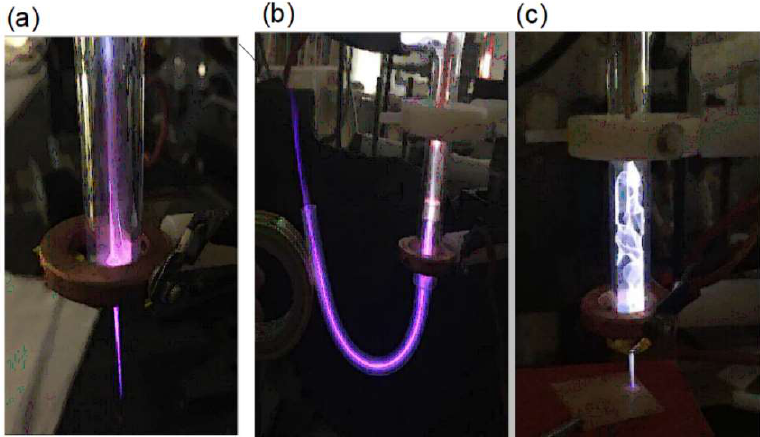
Figure 2. Images of cylindrical plasma devices and plasma jets generated in working gas helium ( a ), with a flexible tube ( b ) and in argon ( c